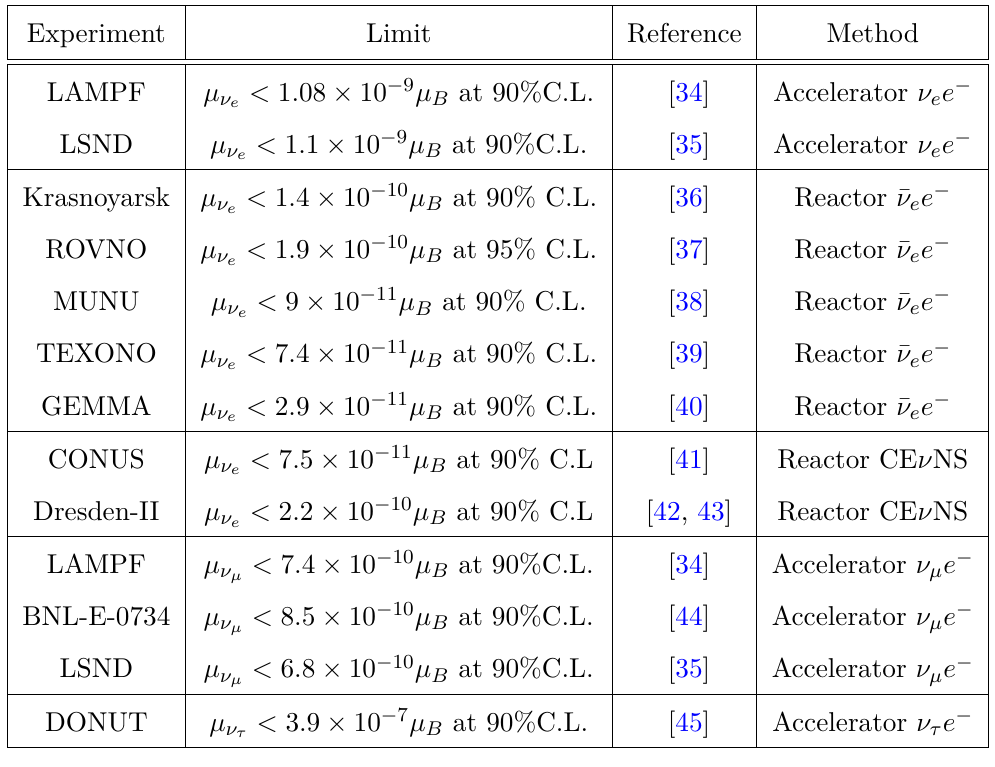
Table 3 . Current experimental constraints on the effective neutrino magnetic moments from short-baseline accelerator and reactor